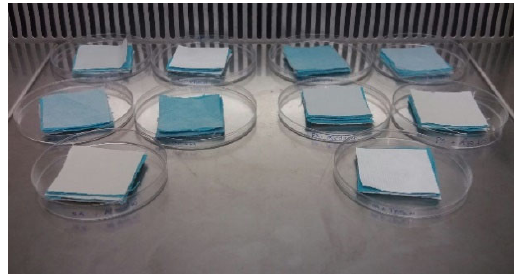
Figure 1. Photo of the contamination test.